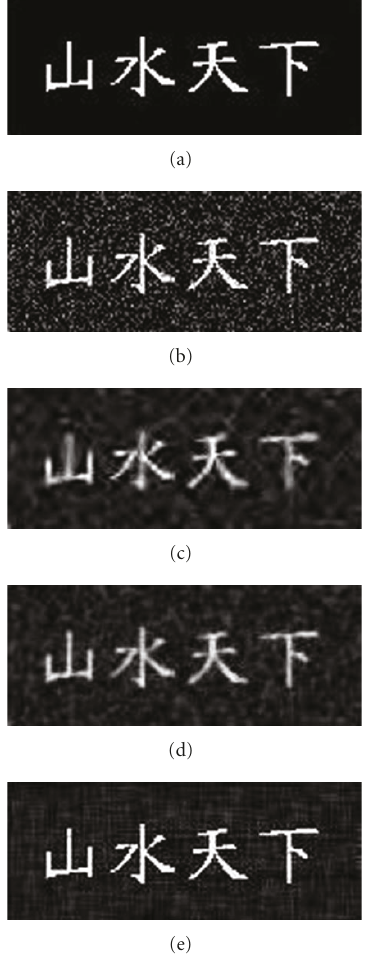
Figure 10: (a) Four Chinese words, (b) noisy image with Gaussian noise with σ = 0 . 05, (c) denoised image by wavelet, PSNR = 16 . 453, (d) denoised image by ADF, PSNR = 17 . 244, and (e) the proposed procedure, PSNR = 20 .